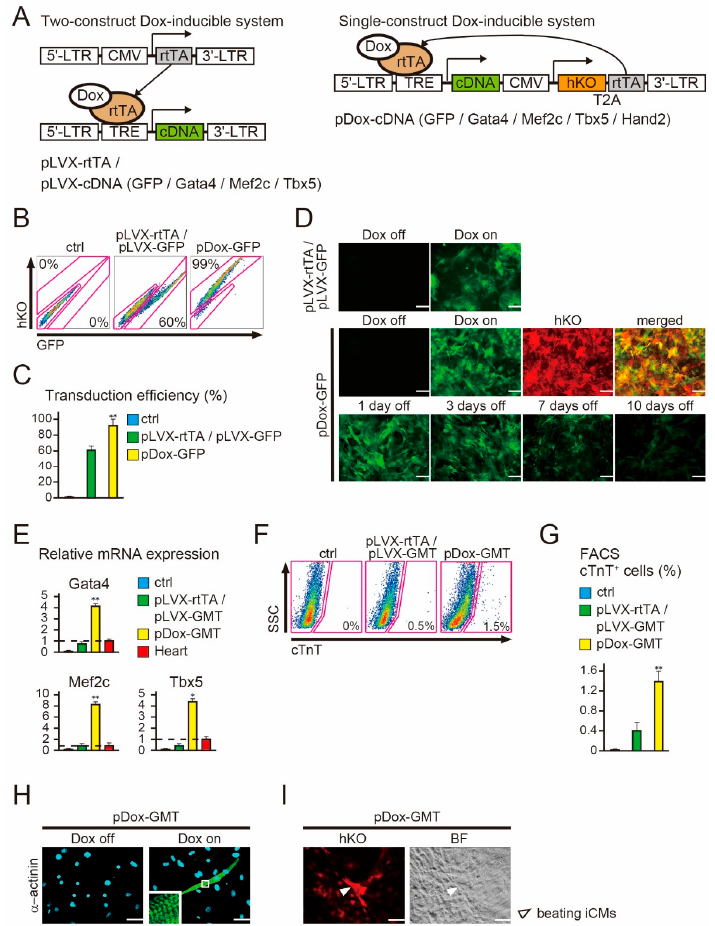
Figure 1. Single-construct, polycistronic doxycycline (Dox)-inducible lentiviral vectors promote cardiac reprogramming ( A ) Conventional two-construct, Dox-inducible lentiviral vectors (left, pLVX-reverse tetracycline transactivator (rtTA) and pLVX-cDNA (green fluorescent protein (GFP), Gata4, Mef2c, Tbx5)), and the new single-construct, polycistronic Dox-inducible lentiviral vectors (right, pDox-cDNA (GFP, Gata4, Mef2c, Tbx5, Hand2)). Horizontal arrows indicate gene expression and diagonal arrows indicate rtTA binding to the tetracycline response element (TRE); ( B ) Fluorescence activated cell sorting (FACS) analysis of GFP or Humanized Kusabira-Orange fluorescence (hKO) expression one week after pLVX-rtTA/pLVX-GFP or pDox-GFP transduction in mouse embryonic fibroblasts (MEFs).; ( C ) quantitative data of ( B ) are shown in ( n = 3, independent triplicate experiments); ( D ) MEFs were infected with pLVX-rtTA/pLVX-GFP or pDox-GFP and were imaged prior to (Dox off), or one week after Dox addition (Dox on), and at the indicated time points after Dox withdrawal (1, 3, 7, and 10 days off). All images were obtained using constant exposure times and identical camera settings; ( E ) qRT-PCR for Gata4, Mef2c, Tbx5 expression in MEFs, pLVX-rtTA/pLVX-GMT-transduced MEFs, and pDox-GMT-transduced MEFs cultured for one week after Dox addition, as well as in heart tissue ( n = 3 independent triplicate experiments). Data were normalized to the values of heart tissue (the dash lines); ( F ) FACS analyses for cardiac troponin T (cTnT) expression one week after transduction, in the presence of Dox.; ( G ) quantitative data of ( F ) ( n = 3 independent triplicate experiments); ( H ) immunocytochemistry for α -actinin in pDox-GMT-transduced MEFs cultured without or with Dox (i.e., Dox off or Dox on) for four weeks. The high-magnification view in the inset shows the sarcomeric organization; ( I ) spontaneously beating cardiomyocyte-like cells (iCMs) generated with pDox-GMT transduction, with Dox, after four weeks (arrowheads), corresponding to Movie S1. All data are presented as mean ± SD. * p < 0.05, ** p < 0.01 vs. the relevant control. The scale bars represent 100 µ